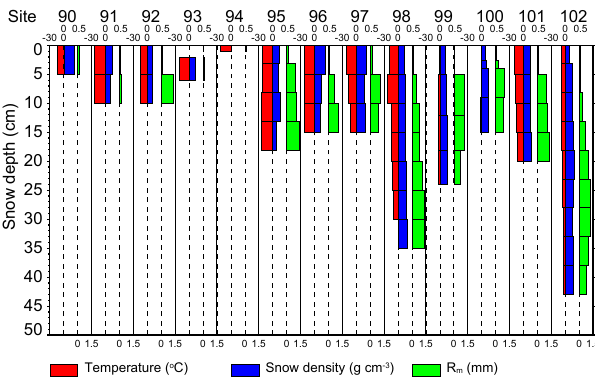
Figure 3. Vertical temperature, snow density, and measured snow grain radius ( R m ) profiles at each site during the 2014 Chinese snow survey.